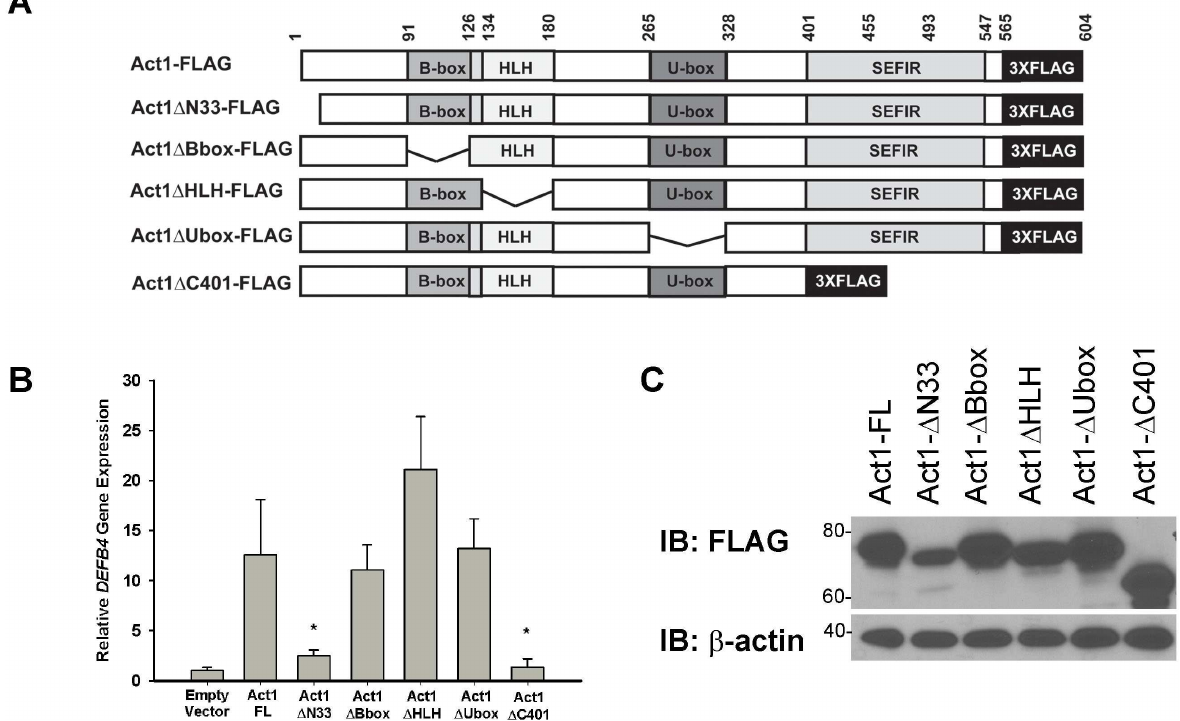
Fig 5. Regions of Act1 necessaryfor gene expression. (A) Schematic representation of various FLAG-tagged Act1 derivatives. Numbers represent amino acid residuelocation. (B) HBE1 cells were transiently transfected with empty vector or various Act1 derivatives. 24h post-transfection, cells were lysed for RNA extraction and real-time PCR analysis of DEFB4 gene expression. C(t) values were normalizedto GAPDH and calibrated to the empty vector control. Error bars represent SEM of 3 independent experiments. * p < 0.05 comparedto Act1-FL (C) 30 μ g whole cell lysate was immunoblotted with anti-FLAG antibody to confirm expressionof FLAG- tagged Act1 derivative. β -actin was used as a